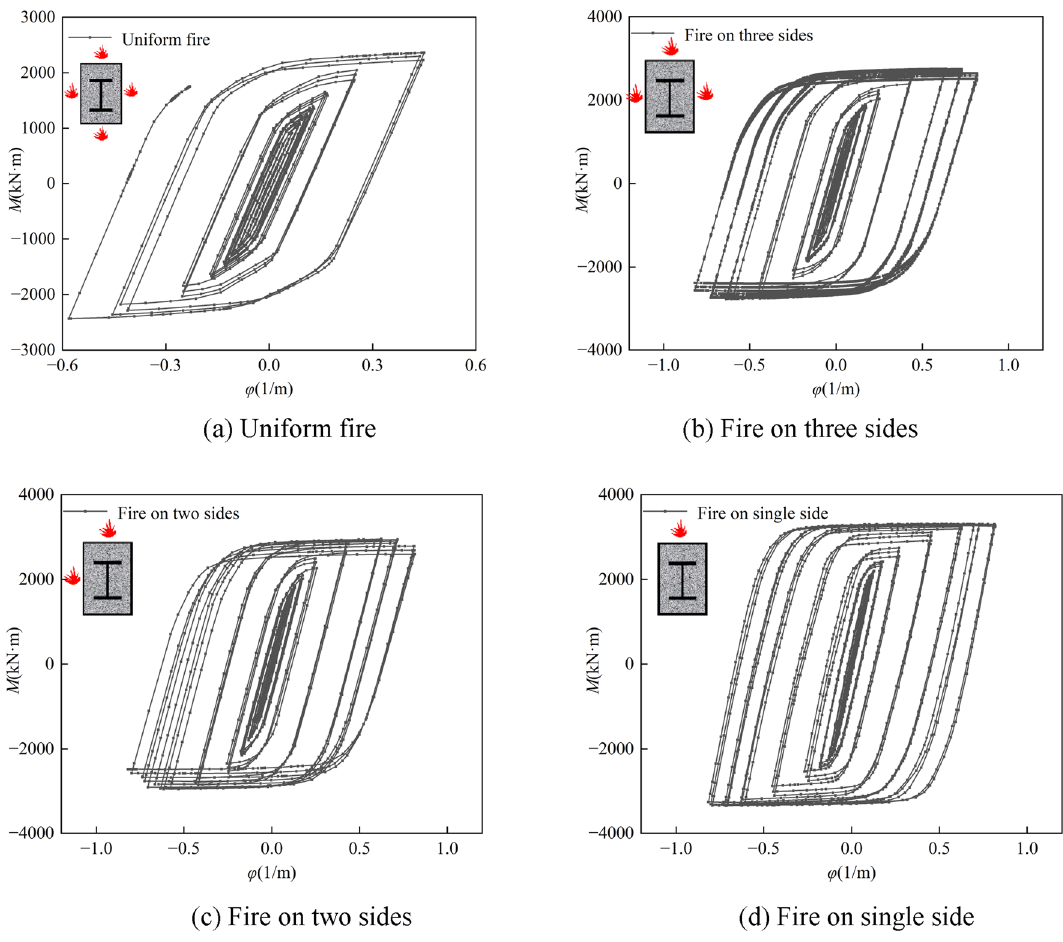
Figure 15. Hysteresis curves of M-φ relations.